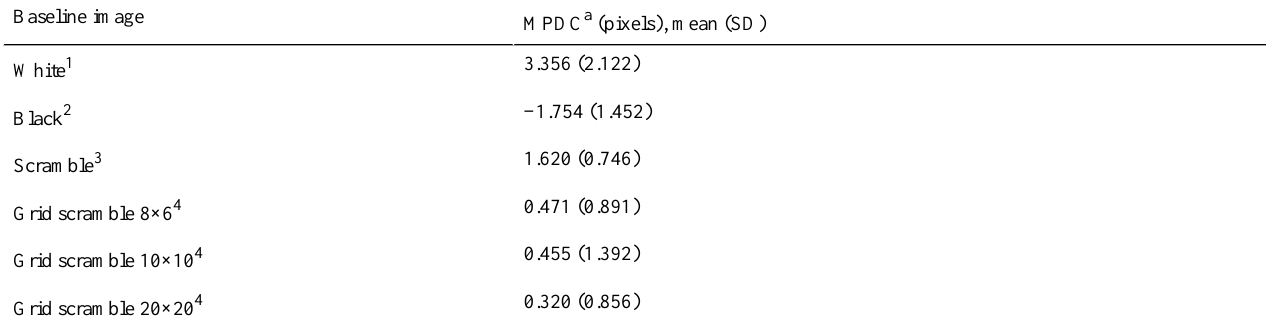
Table 3. Results for the baseline image test (experiment 1). Different superindices indicate significant intergroup differences.